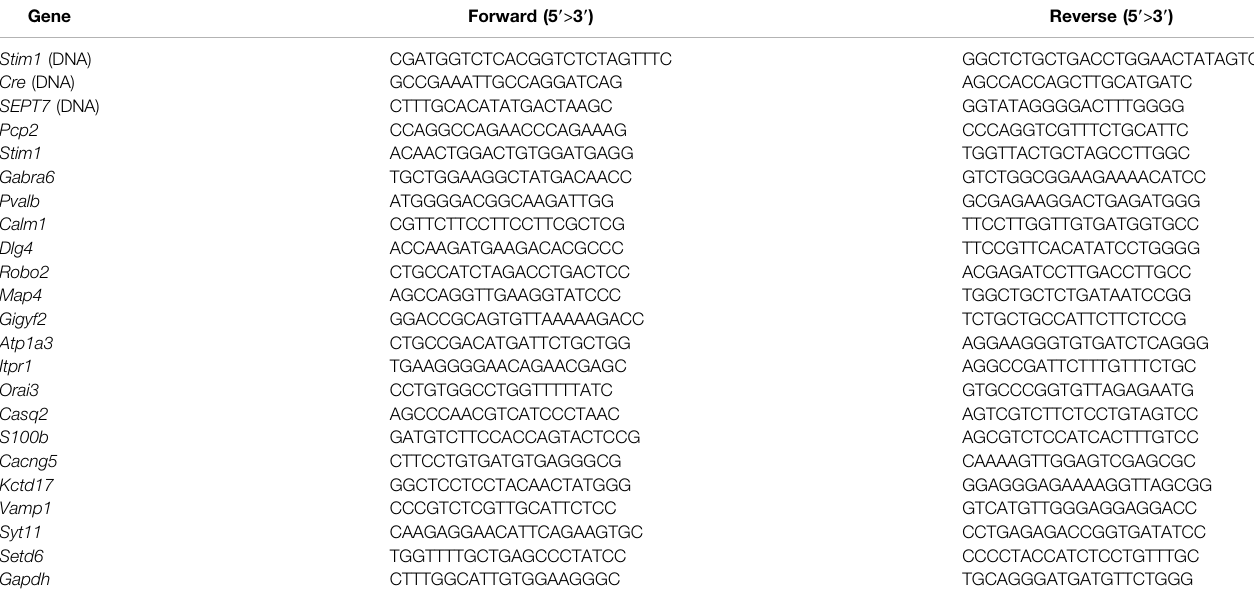
TABLE 1 | Primers used for genotyping transgenic mice and for quantitative real-time PCR.